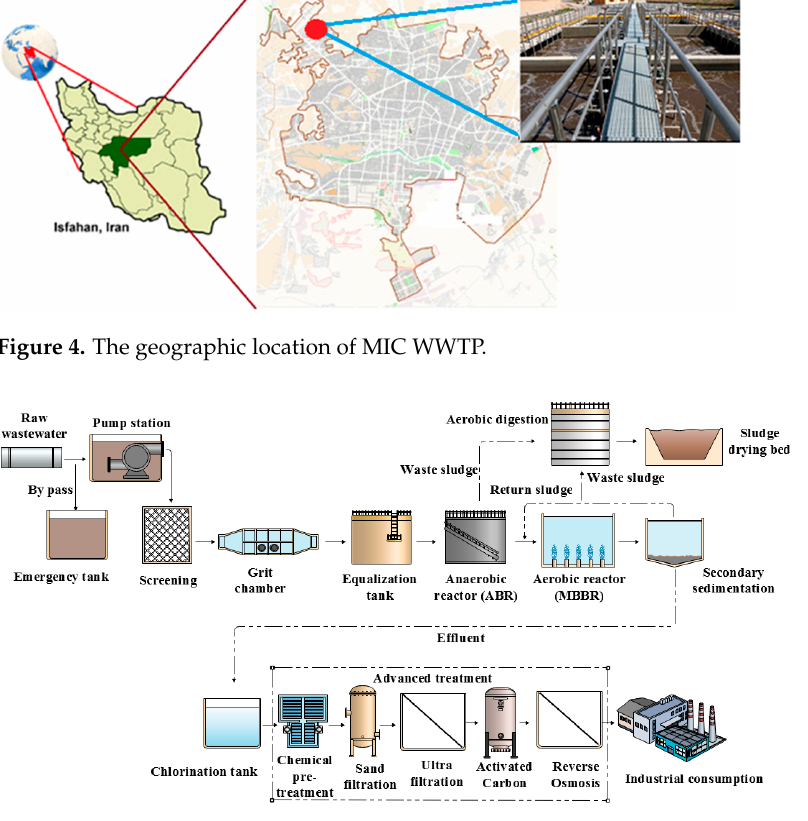
Figure 5. Process flow diagram of the MIC WWTP.